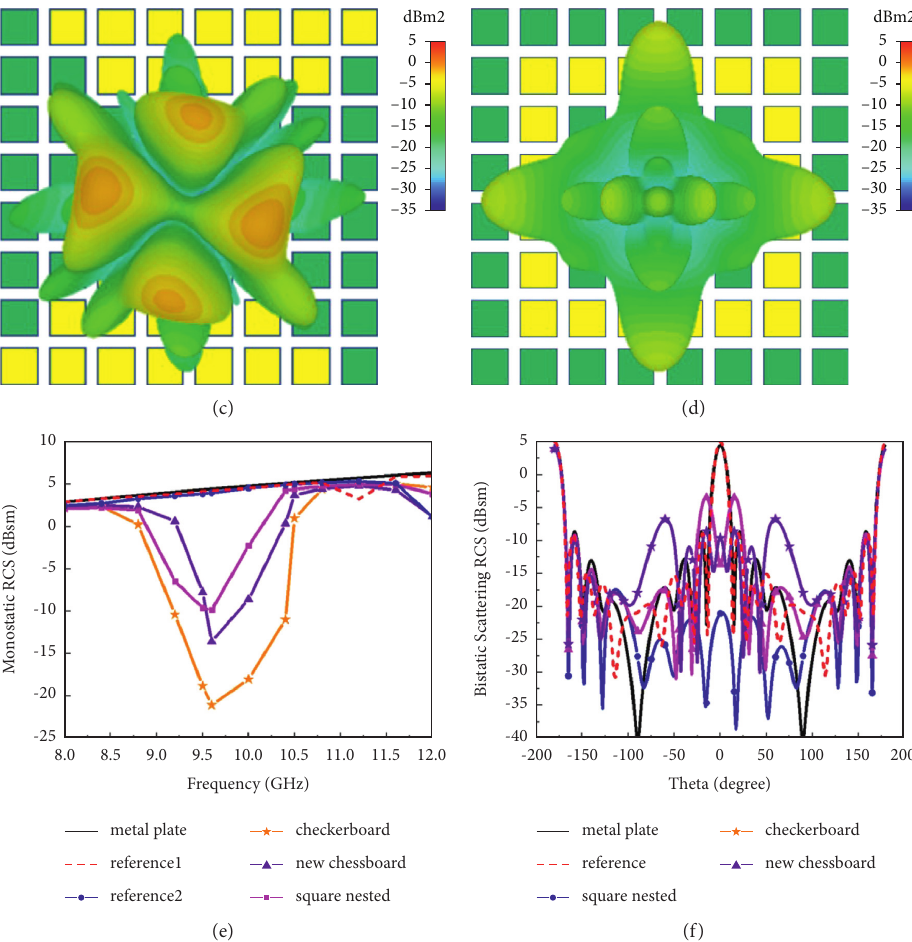
Figure 6: Simulated scattering results of different layouts; (a) reference antenna (when all PIN diodes are of “ON” or “OFF” states, here just take all “ON” states as an example); (b) checkerboard layout; (c) new chessboard layout; (d) “0101” square ring nested layout; (e) monostatic RCS variation curves with frequency; (f) bistatic RCS changing curves with angle.